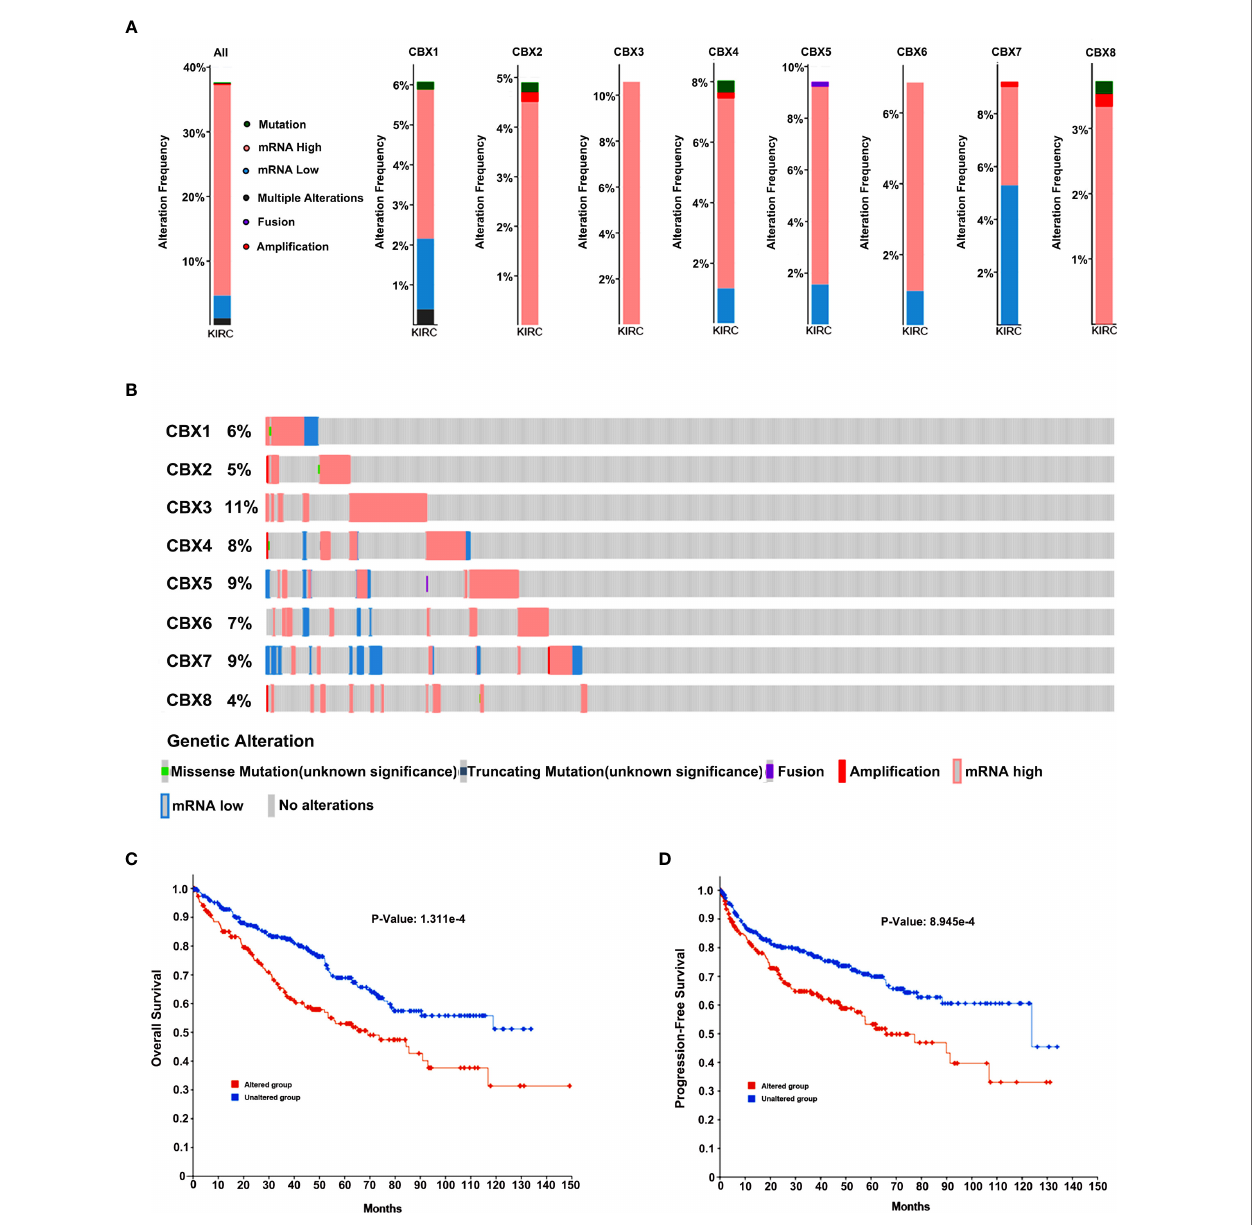
FIGURE 12 | Genetic alteration in CBXs and their relationship with OS and DFS of ccRCC patients (cBioPortal). The genetic alterations rates of CBX1, CBX2, CBX3, CBX4, CBX5, CBX6, CBX7 and CBX8 (A, B) . Correlation of CBXs gene alterations with OS and DFS in patients with ccRCC (C, D)